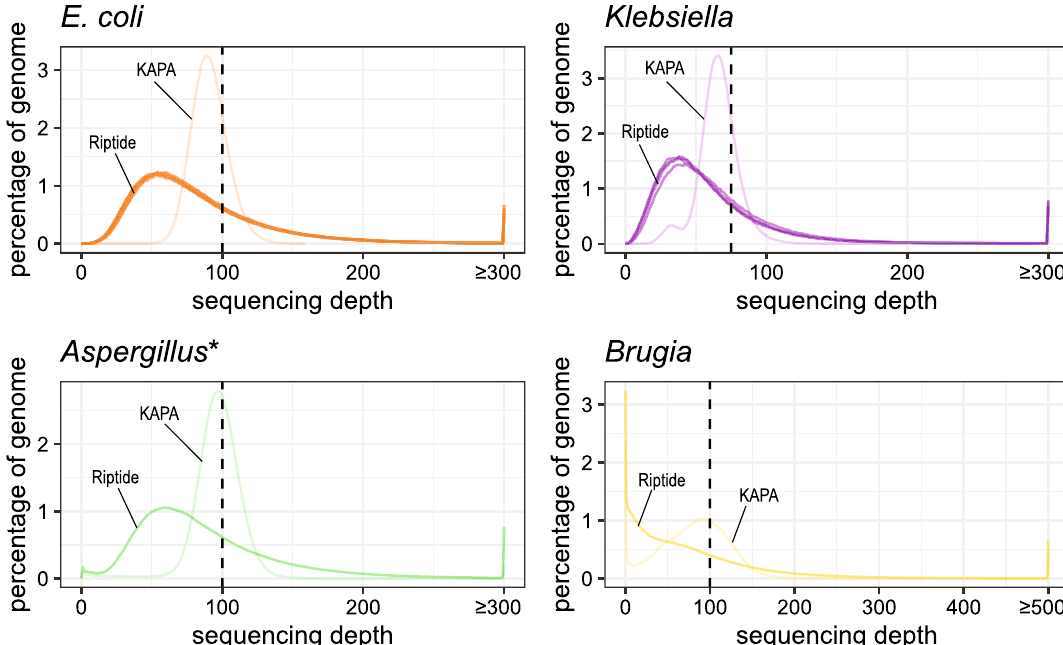
Figure 4. Histograms of sequencing depth in Riptide and non-Riptide libraries. For each library, randomly subsampled reads were mapped to a reference containing the source genome, and non-primary alignments were subsequently removed. All Riptide replicates are shown for E. coli and Klebsiella , while distributions for Aspergillus and Brugia were generated from merged Riptide libraries. Vertical dotted lines correspond to the expected mode of distributions based on the sequencing depth targeted with subsampling procedures. *Regions having zero sequencing depth which largely represent tracts of Ns in the scaffolded Aspergillus assembly were omitted from this